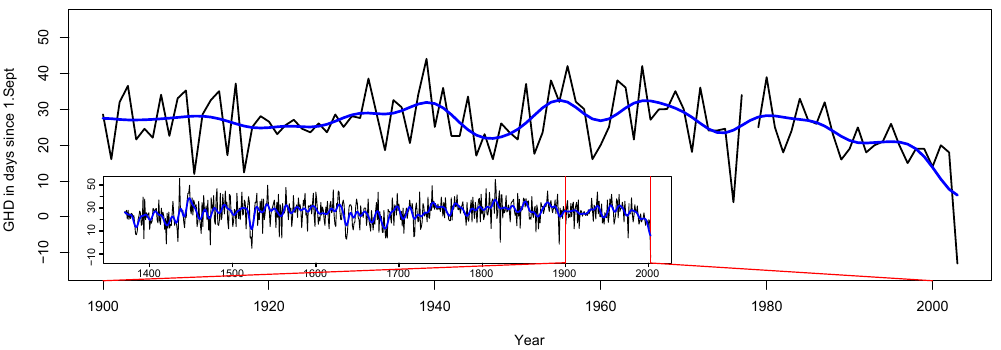
Fig. 1. GHD series (Chuine et al., 2004) of the Burgundy region in France from 1370 to 2003 (in days since 1 September). The instrumental period is emphasised in the main panel as this period is of particular interest in this study. Blue line: decadal variations (low-pass filtered data using a 1/10 year